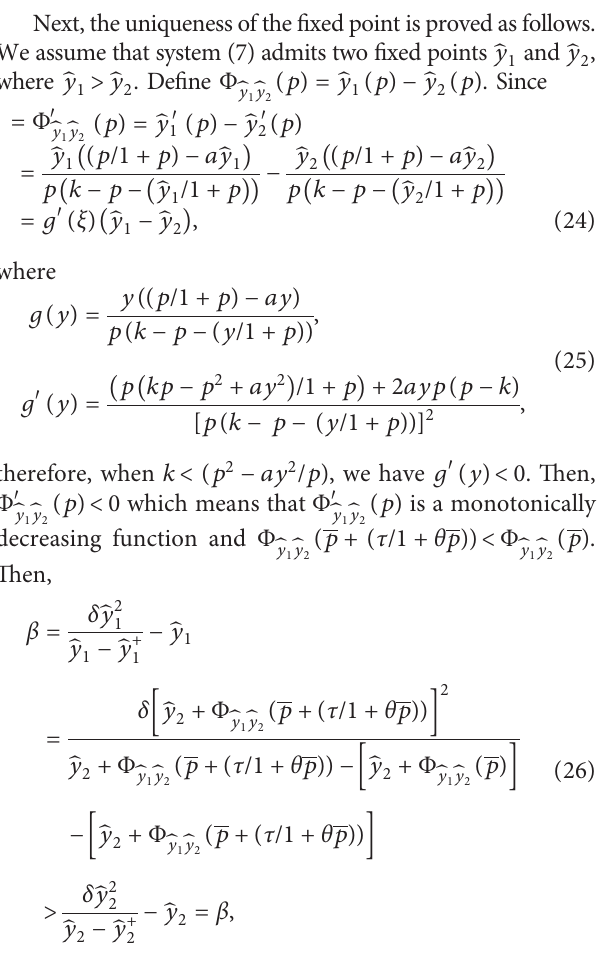
� 0 . 2 , a � 0 . 3 , φ � 0 . 01 , a � 0 . 05 , and ET � 2 . 5. 1 2 1 2